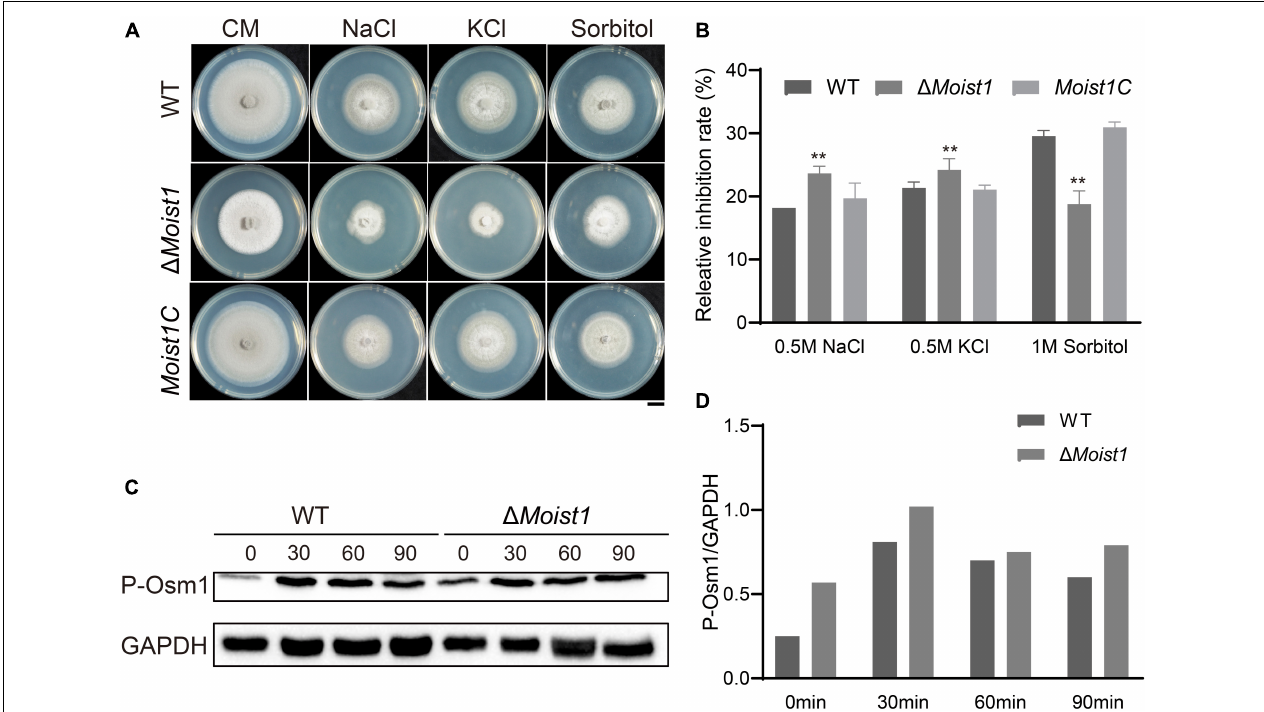
FIGURE 6 | Deletion of MoIst1 increases sensitivity to hyperosmotic stress. (A) 0.5 M NaCl, 0.5 M KCl, and 1 M sorbitol were added separately to CM to culture WT, (cid:49) Moist1 and Moist1C . Bar = 1 cm. (B) Relative inhibition rates of WT, (cid:49) Moist1, and Moist1C on CM with 0.5 M NaCl, 0.5 M KCl and 1 M Sorbitol. The standard deviation is represented by error bars. Tukey’s test was used to test significant differences: ** P < 0.01. (C) Phosphorylated Osm1 levels were detected. GAPDH was used as an internal reference for protein standardization by Western blot. (D) The content of phosphorylated Osm1 relative to GAPDH at different time points in WT and (cid:49) Moist1